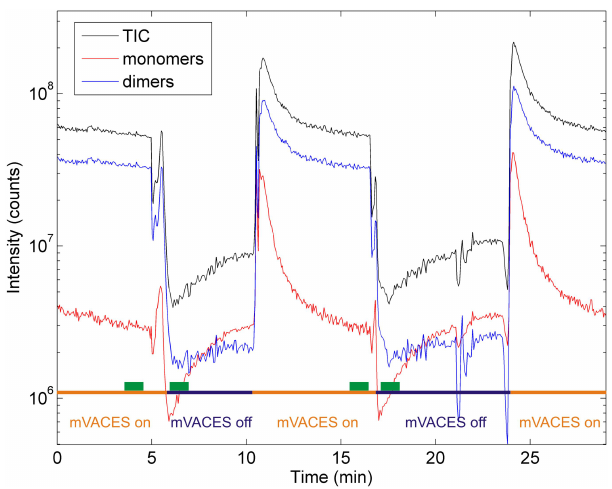
Fig. 4. Performance of mVACES aerosol enrichment during lab- oratory testing. TIC: total ion current, monomers: sum of signals m/z 160–240, dimers: sum of signals m/z